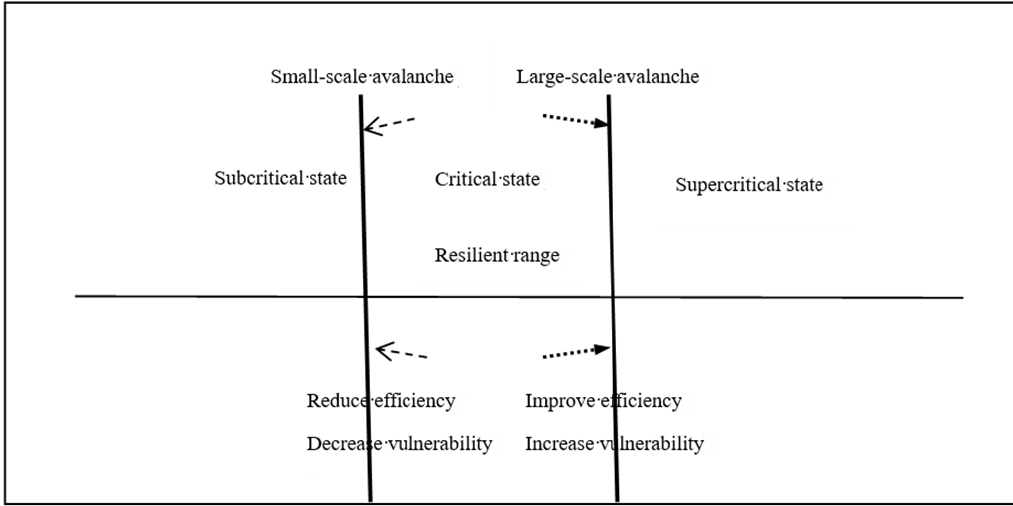
Figure 3. The relationship between Self-Organized Criticality (SOC) and resilience.